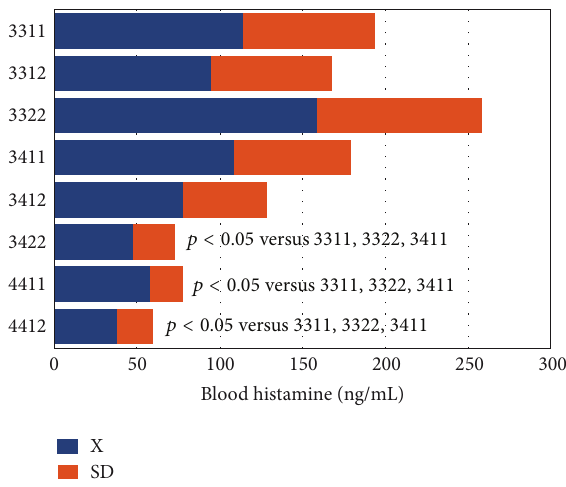
Figure 5: Bigenic genotype ( APOE + PSEN1 )-related histamine levels in Alzheimer’s disease. Concentration of blood histamine in patients with Alzheimer’s disease (AD) according to their bigenic genotypes integrating APOE + Presenilin-1 ( PSEN1 ) in a single haplotype. Haplotype frequencies: 3311 ( APOE -3/3 + PSEN1 -1/1): 16%; 3312 ( APOE -3/3 + PSEN1 -1/2): 27%; 3322 ( APOE -3/3 + PSEN1 - 2/2): 10%; 3411 ( APOE -3/3 + PSEN1 -1/1): 12%; 3412 ( APOE -3/4 + PSEN1 -1/2): 20%; 3422 ( APOE -3/4 + PSEN1 -2/2): 5.5%; 4411 ( APOE - 4/4 + PSEN1 -1/1): 5.5%; 4412 ( APOE -4/4 + PSEN1 -1/2):